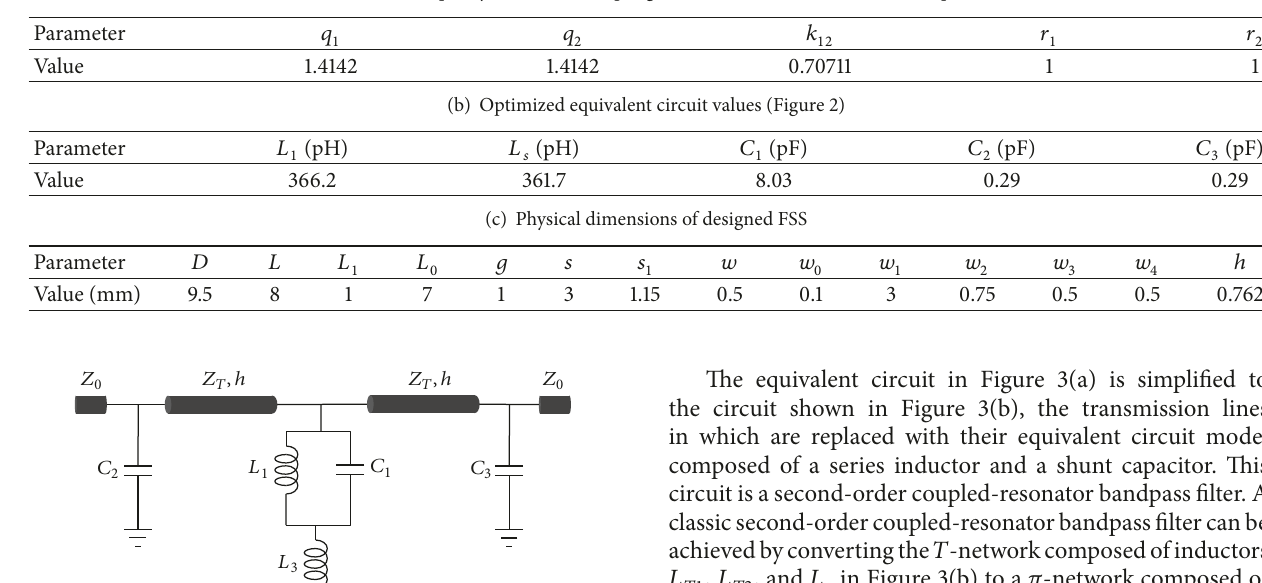
Table 1: Electrical and geometric parameters of the proposed dual-band FSS discussed in Section 2.2. (a) Normalized quality factors and coupling coefficient for Butterworth filter response